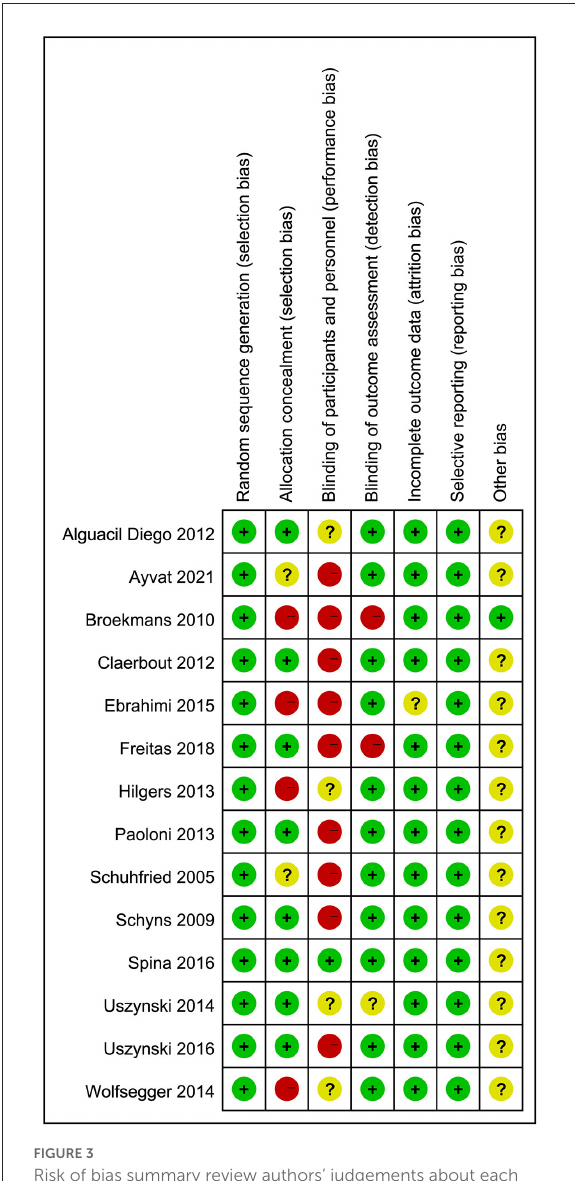
FIGURE3 Risk of bias summary review authors’ judgements about each risk of bias item for each included study.